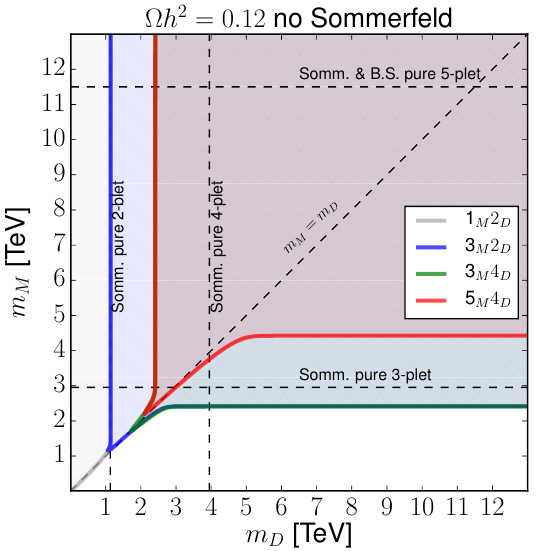
Figure 7. DM candidate parameter space in the perturbative SU(2) L symmetric approximation (for m D ; m M > 100 GeV). Shaded regions enclose all models giving rise to (cid:10) h 2 = 0 : 12 for the 1M2D (in gray), for the 3M2D (in blue), for the 3M4D (in green) and 5M4D (in red). The limits of these contours, represented with thick continuous lines, have been obtained in the pure gauge limit, see text for details. The pure doublet, triplet, quadruplet and quintuplet limits including Sommerfeld corrections (and bounds state (B.S.) formation from [22] in the 5-plet case) are indicated with dashed lines, see section